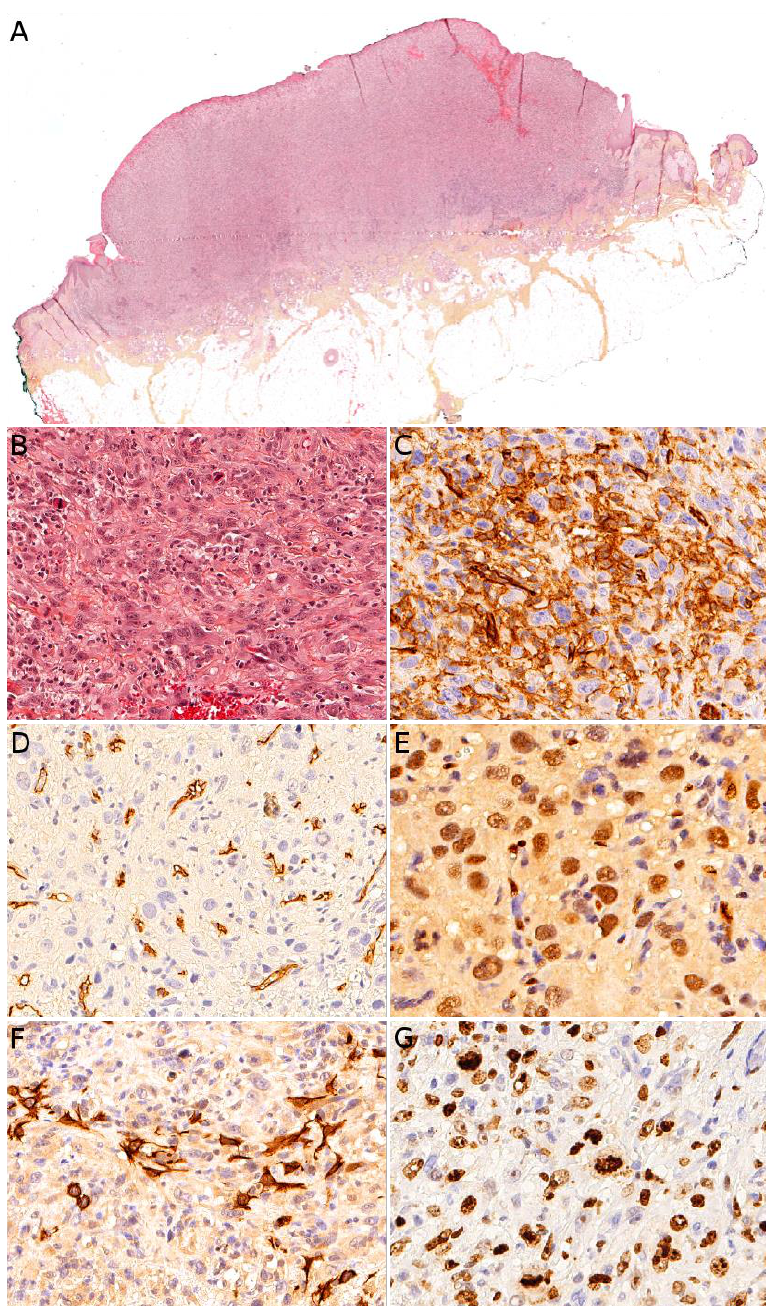
Figure 10. Angiosarcoma: ( A ) Ulcerated nodule (×25); ( B ) atypical epithelioid cells with numerous mitoses and a tripolar mitosis (center of the panel) (×200); ( C ) strong CD31 positivity (×200); ( D ) partial CD34 positivity on small dystrophic vascular structures (×200); ( E ) strong nuclear ERG positivity (×200); ( F ) partial positivity for the cytokeratin marker AE1/AE3 (×200); ( G ) high proliferation index and multiple mitoses (Ki67 ×200).